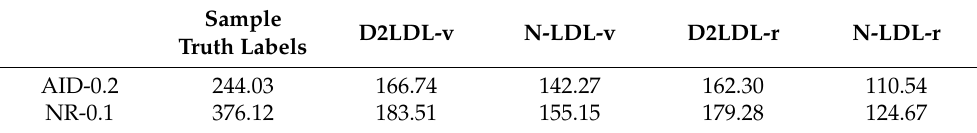
Figure 17. Different label representations and their individual trace values on AID-0.2: ( a ) Sample truth labels, ( b ) D2LDL-v, and ( c ) N-LDL-v. Table 6. Trace values of different label representations.